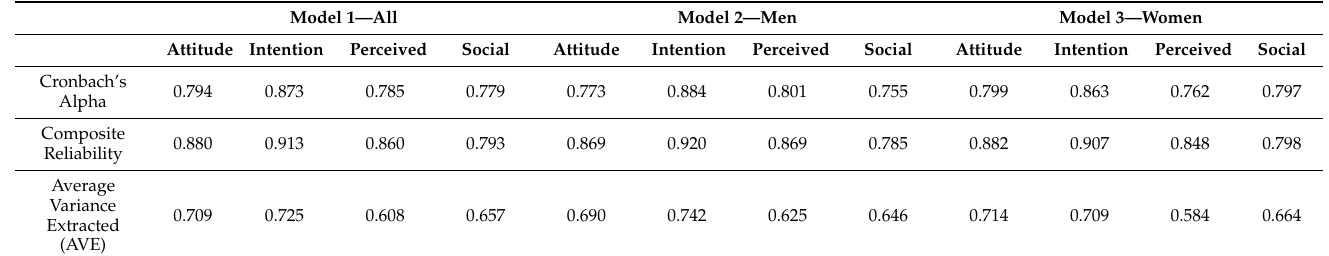
Table 3. Assessment of internal consistency of models.